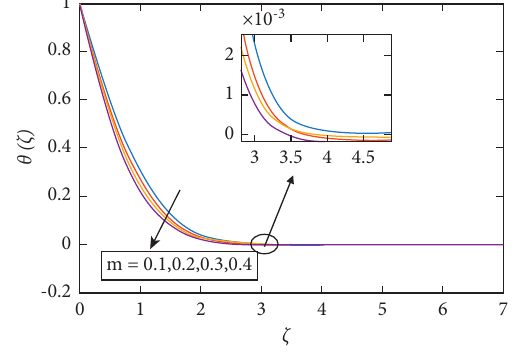
Figure 9: m variation on θ ( ζ ) .